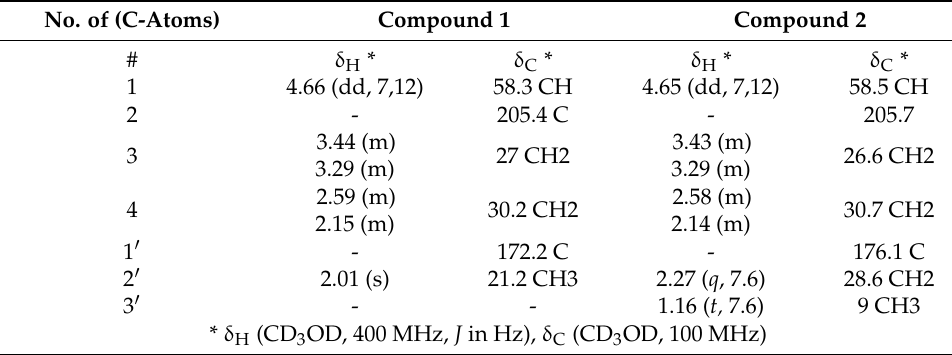
Table 2. One dimension NMR data of compounds 1 and 2